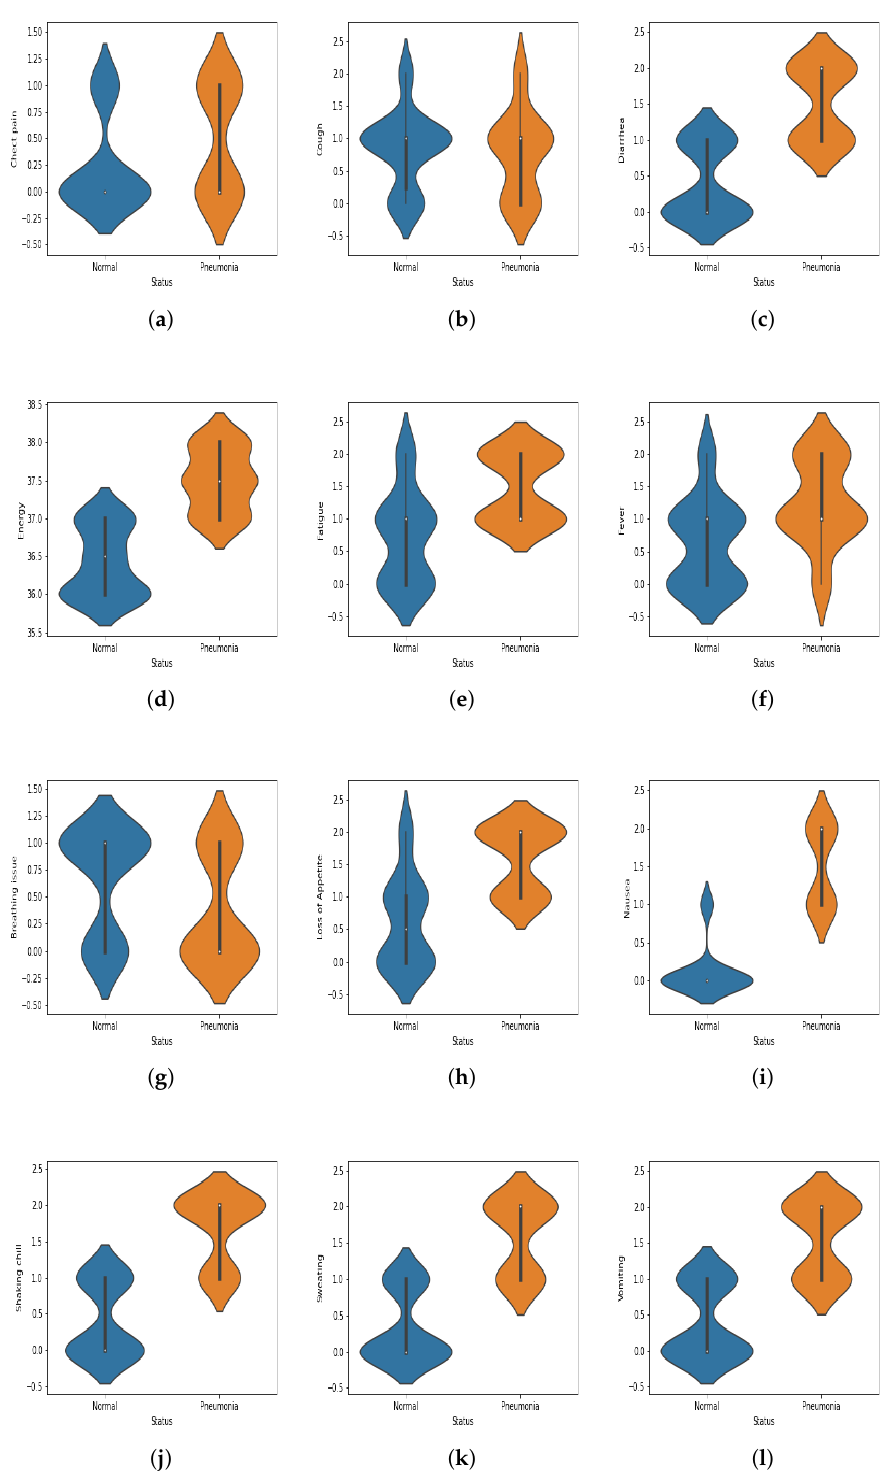
Figure 11. ( a – l ) Violin plots corresponding to each feature used in the